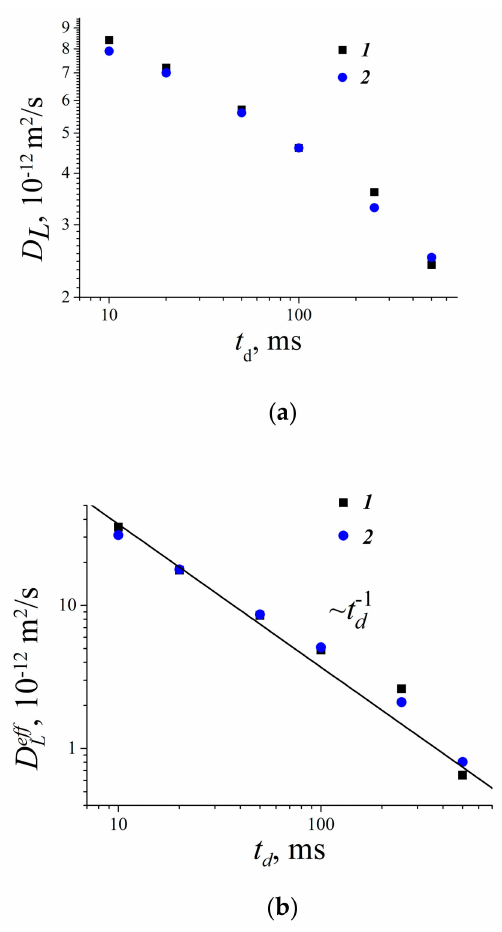
Figure 67. The dependence of the blood lipid self-diffusion coefficient D L ( t d ) on diffusion time t d at 20 ◦ C (1) and 25 ◦ C (2) ( a ). The dependence of effective blood lipid self-diffusion coefficient D eff L ( t d ) on diffusion time t d at 20 ◦ C (1) and 25 ◦ C (2), D p = 1.9 · 10 − 12 m 2 /s ( b ). Reprinted with permission from [171]. Copyright 2016 Springer